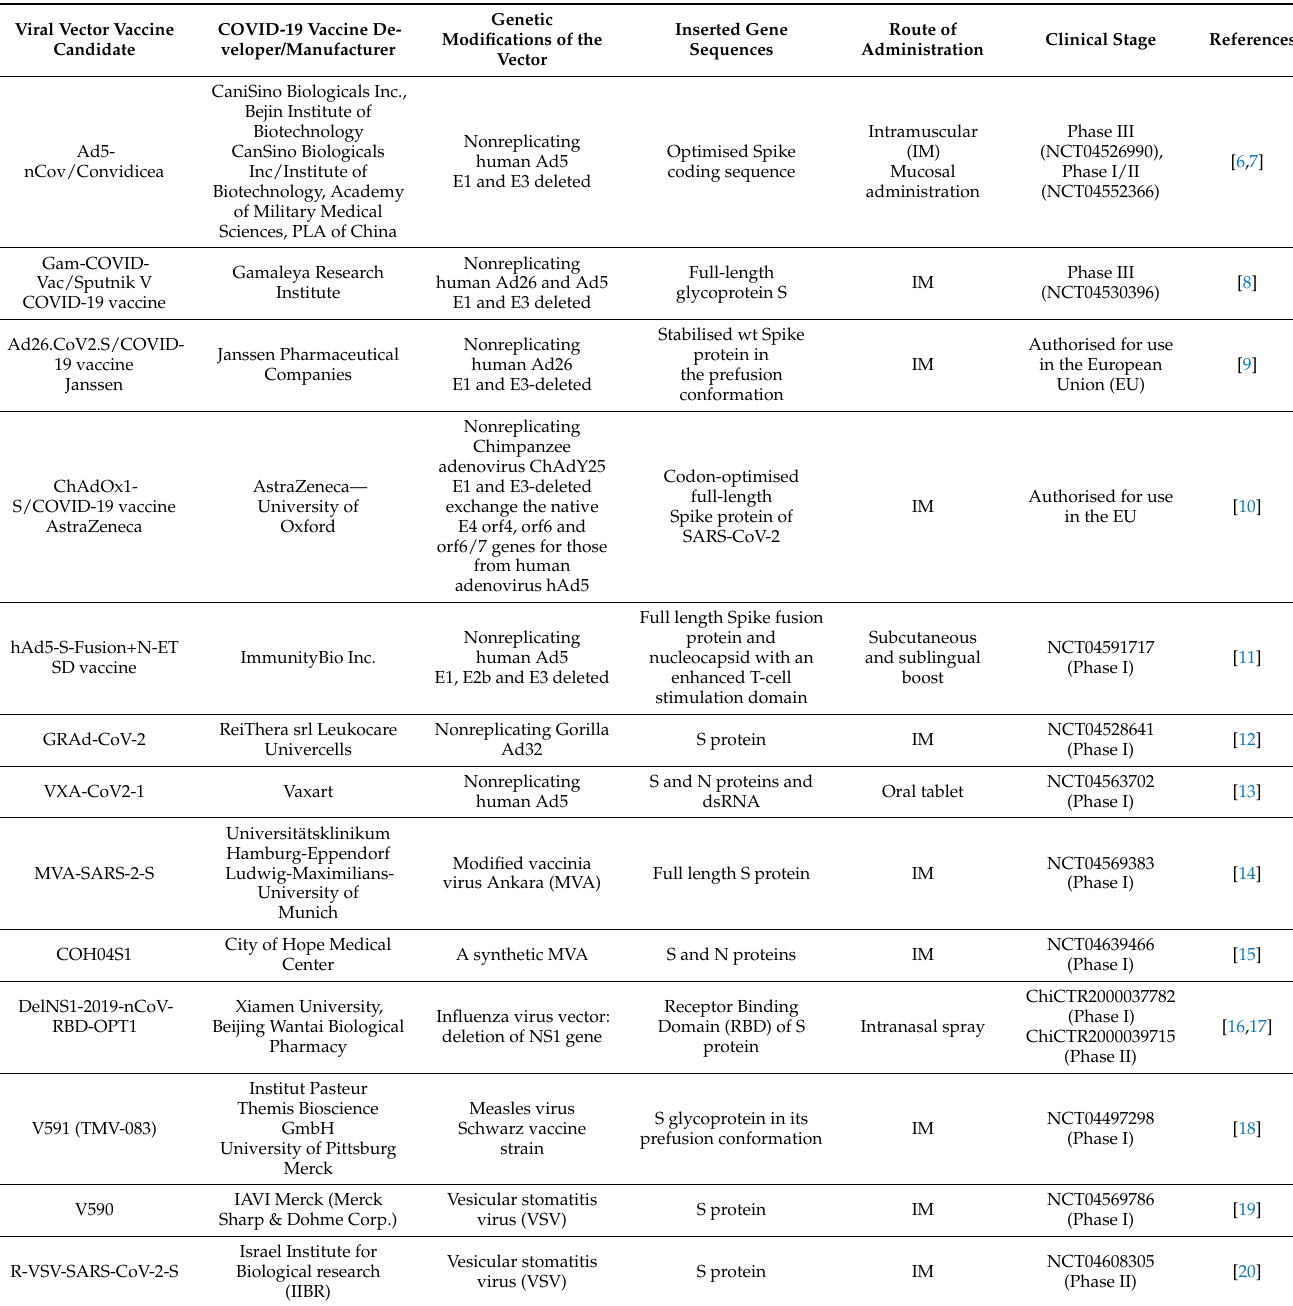
Table 1. Viral vector based vaccines against SARS-CoV-2 that are in clinical development or already authorised for use in the European